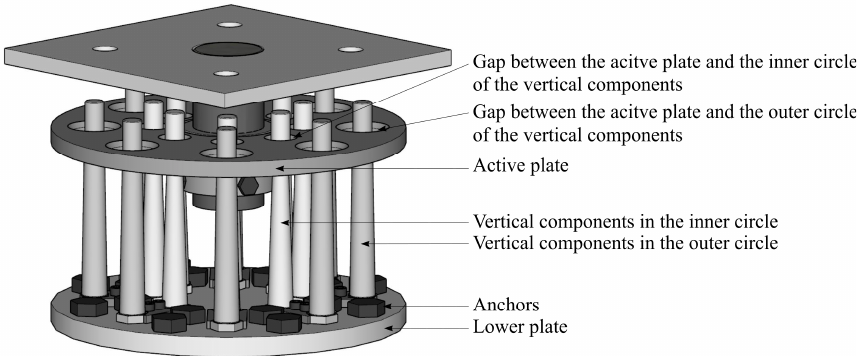
Figure 5. The geometry and components of the innovative steel seismic energy dissipation device.